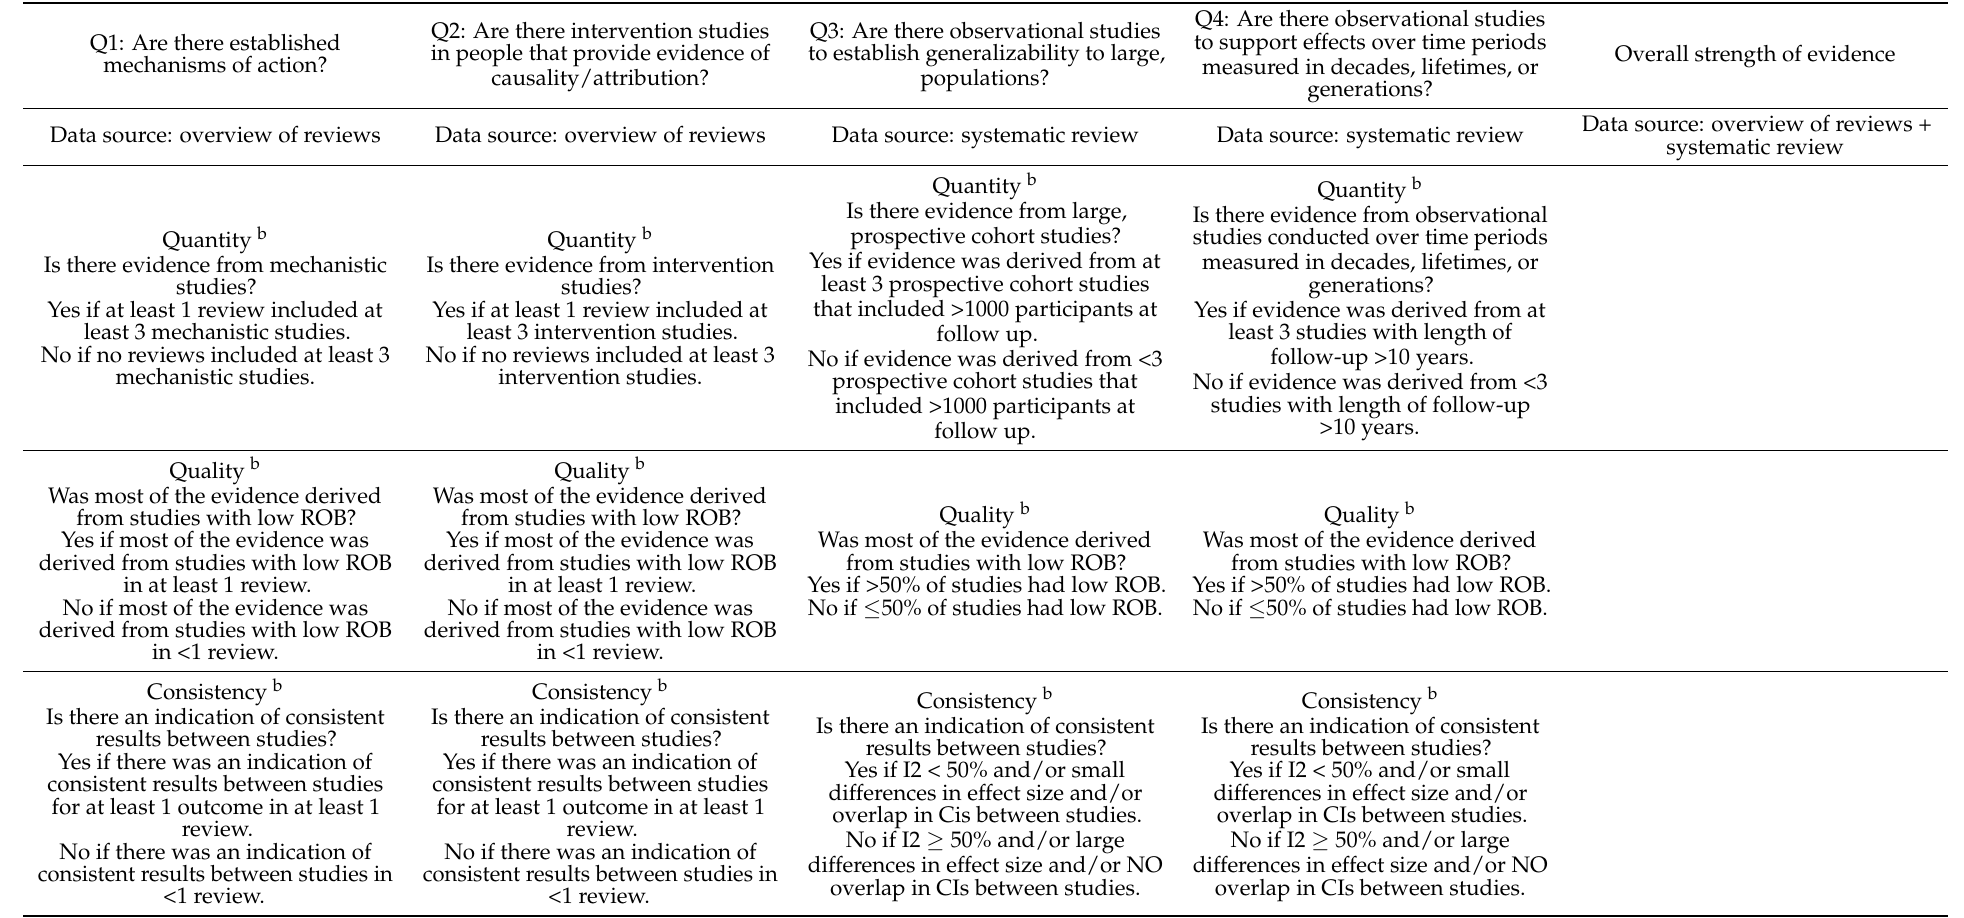
Table 2. Overview of the criteria developed and used in the application of the Hierarchies of Evidence Applied to Lifestyle Medicine (HEALM) approach a